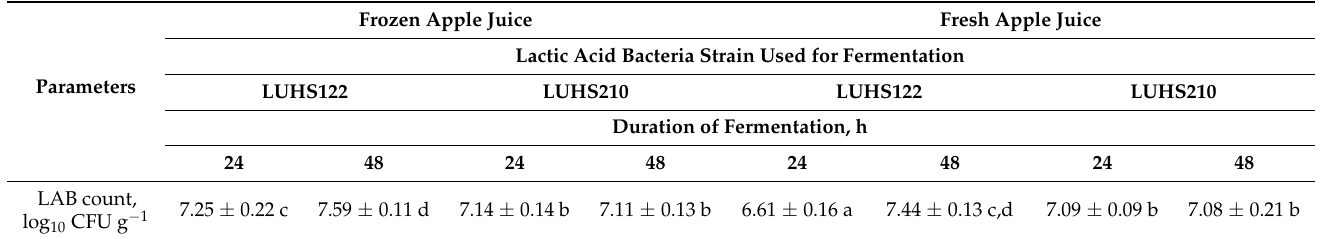
Table 6. Viable lactic acid bacteria count in fermented apple juice samples.